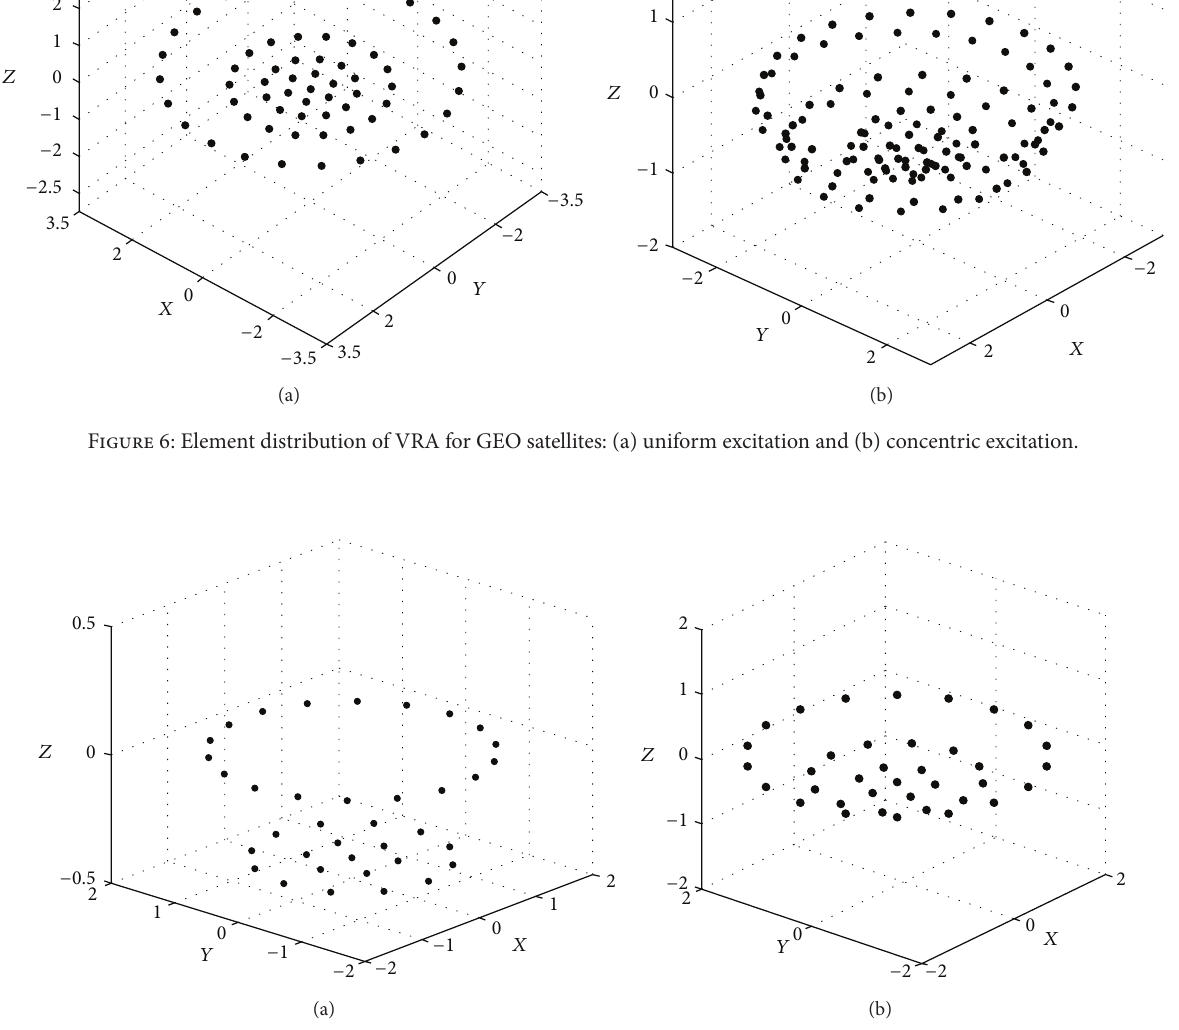
Figure 7: Element distribution of VRA for MEO satellites: (a) uniform excitation and (b) concentric excitation.